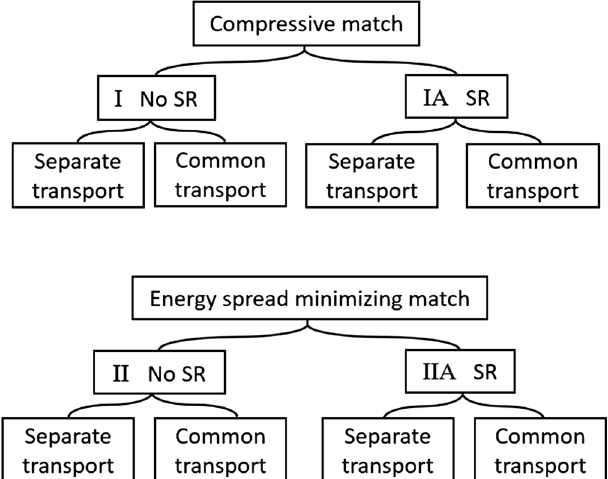
FIG. 2. Classification of longitudinal matches for ERLs